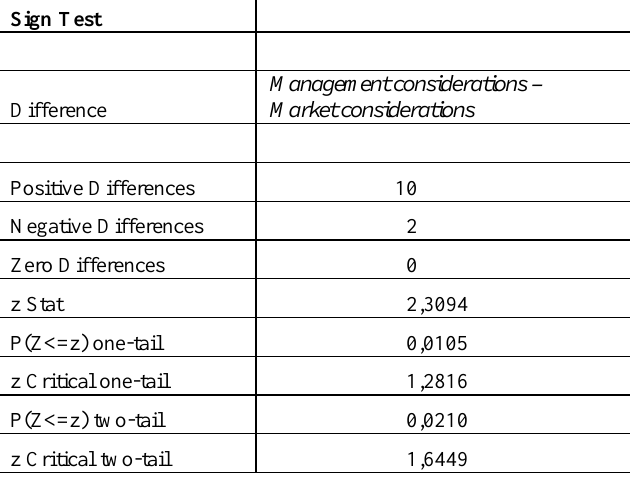
Table 2: Sign test